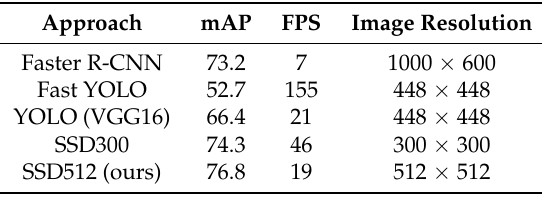
Performance evaluation of our SSD-based detector over KITTI dataset against state-of-the-art approaches.